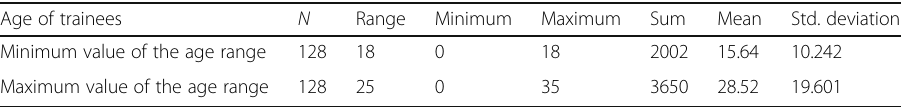
Table 2 Age of sponsored TVET